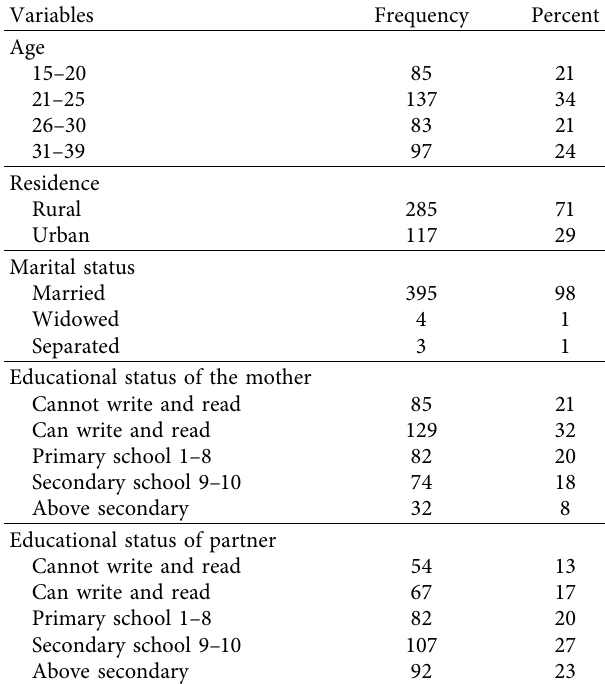
Table 2: Past and current obstetric history of pregnant women attending antenatal care and taking iron-folate, at Shalla district health facilities, West Arsi Zone, Southwest Ethiopia, 2019 ( N �